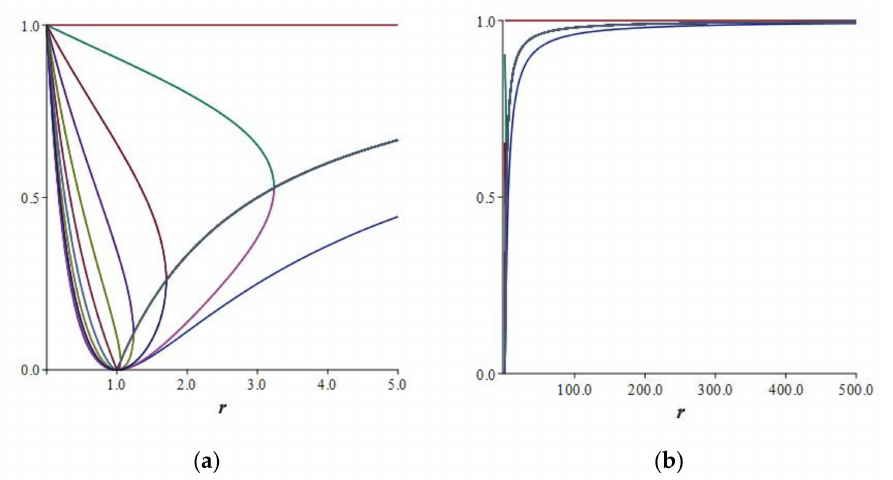
Figure 14. The graphs of the eigenvalues of the amplification matrix H 2 as a function of the mesh ratio r for N = 20. ( a ) r ∈ [ 0,5 ] . ( b ) r ∈ [ 1,500 ]